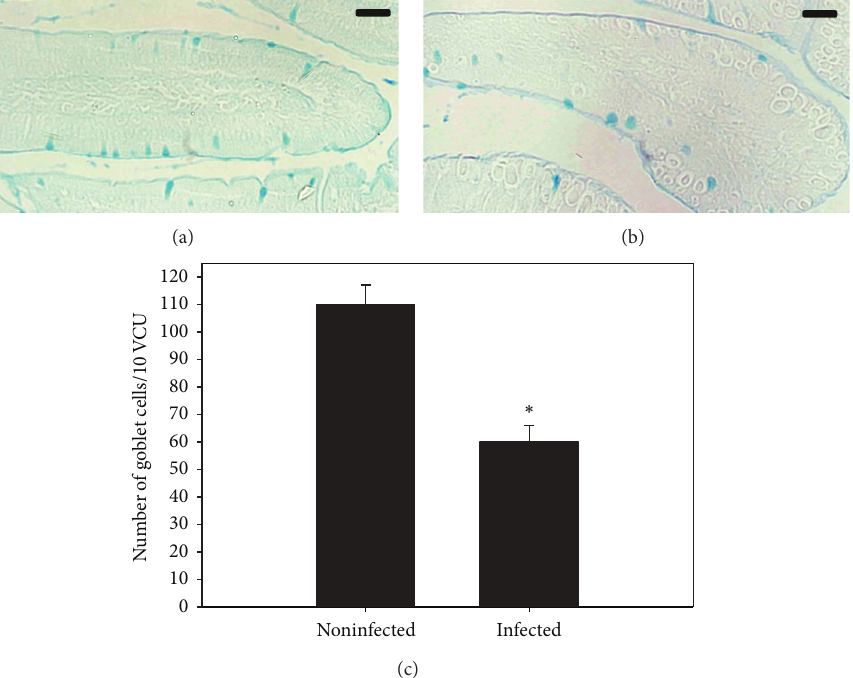
Figure 3: Changes in goblet cell numbers in mouse jejunum infected with E. papillata . (a) Noninfected jejunum with more goblet cells. (b) Non-infected treated mouse jejunum. Sections are stained with Alcian blue. Bar = 25 𝜇 m. (c) Number of goblet cells in jejunum of mice at day 5 p.i. Values are means ± SD. ∗ Significant at 𝑃 ≤ 0.05 . 𝑛 = 10 .